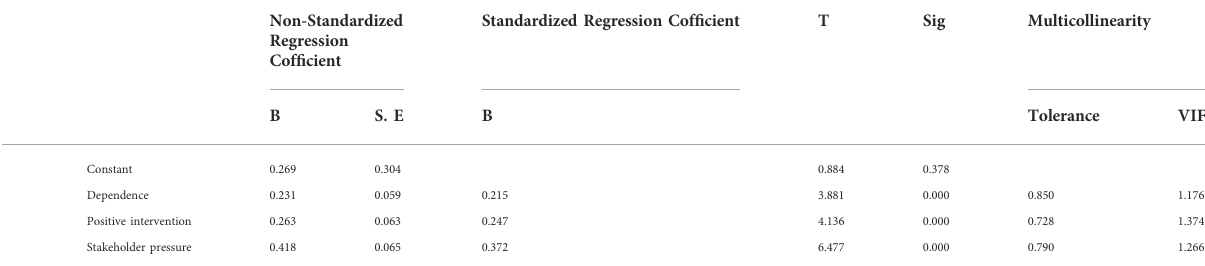
TABLE 6 Test results of